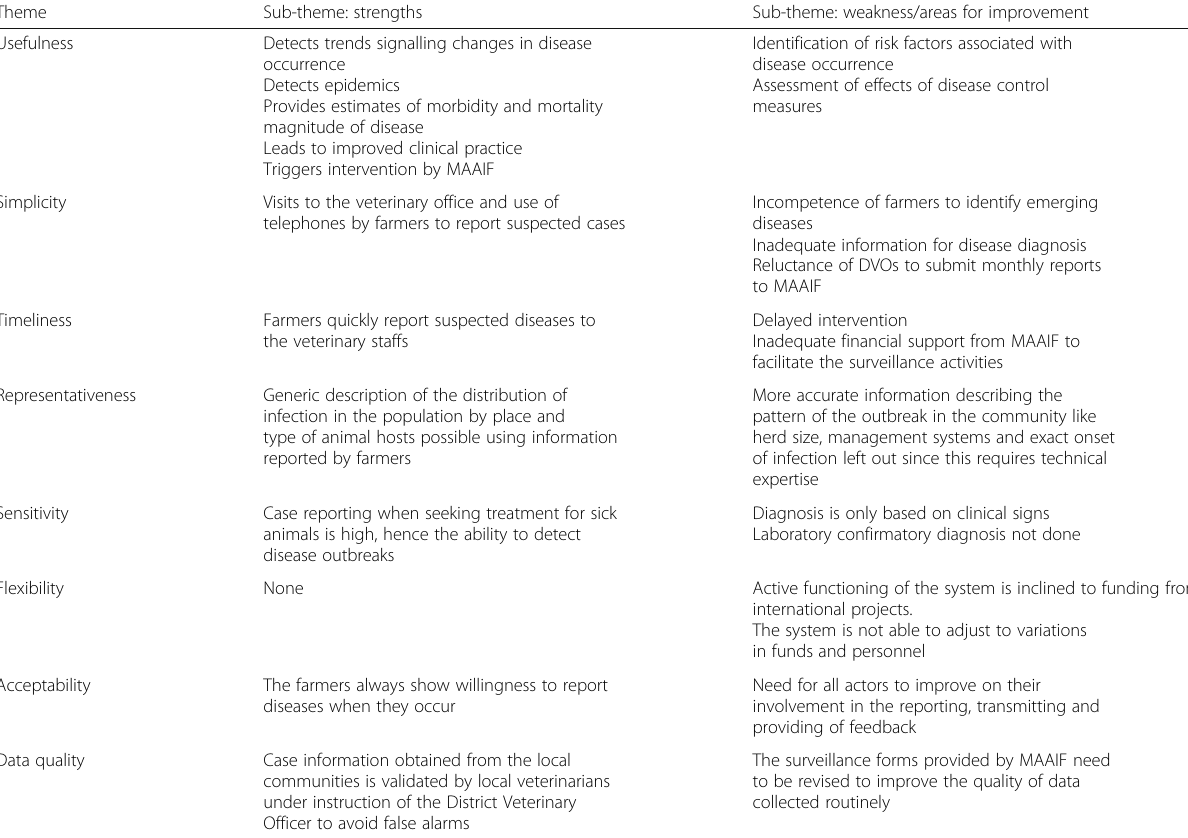
Table 4 A summary of the mid-level livestock surveillance system evaluation